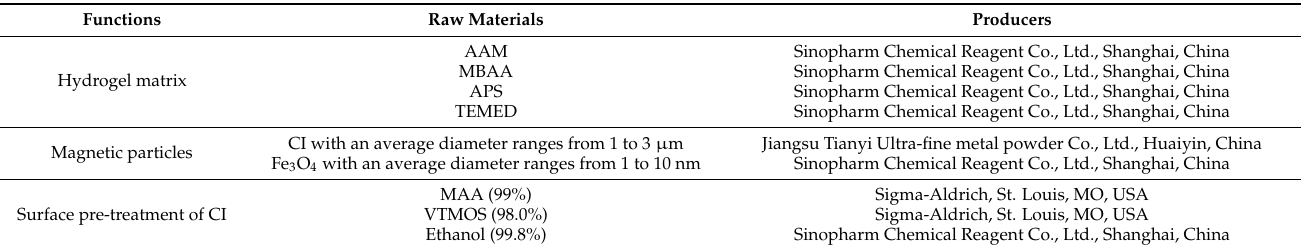
Table 1. The raw materials and its producer for preparing magnetic